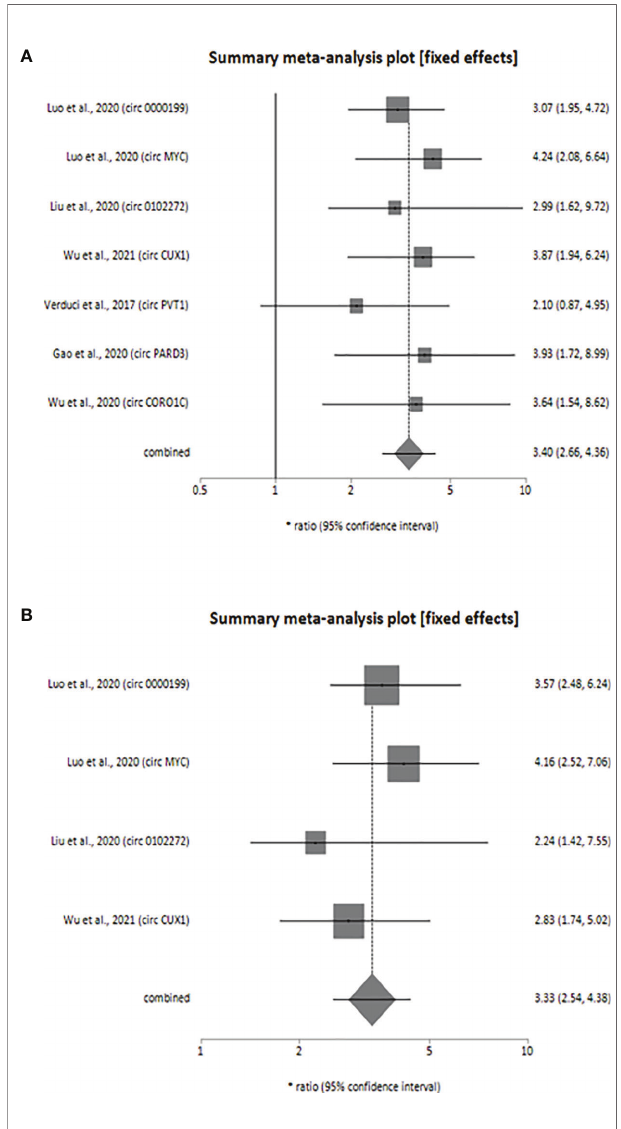
FIGURE 2 | Forest plot showing the combined HR along with individual HR values at 95% CI for the upregulated circRNA pro fi les in predicting the overall survival of patients with HNSCC (A) univariate analysis, (B) multivariate analysis. Square shapes indicate the effect size of each upregulated circRNA pro fi le, while diamond shapes indicate the overall effect size. The 95% CI of each effect sizes are indicated by respective